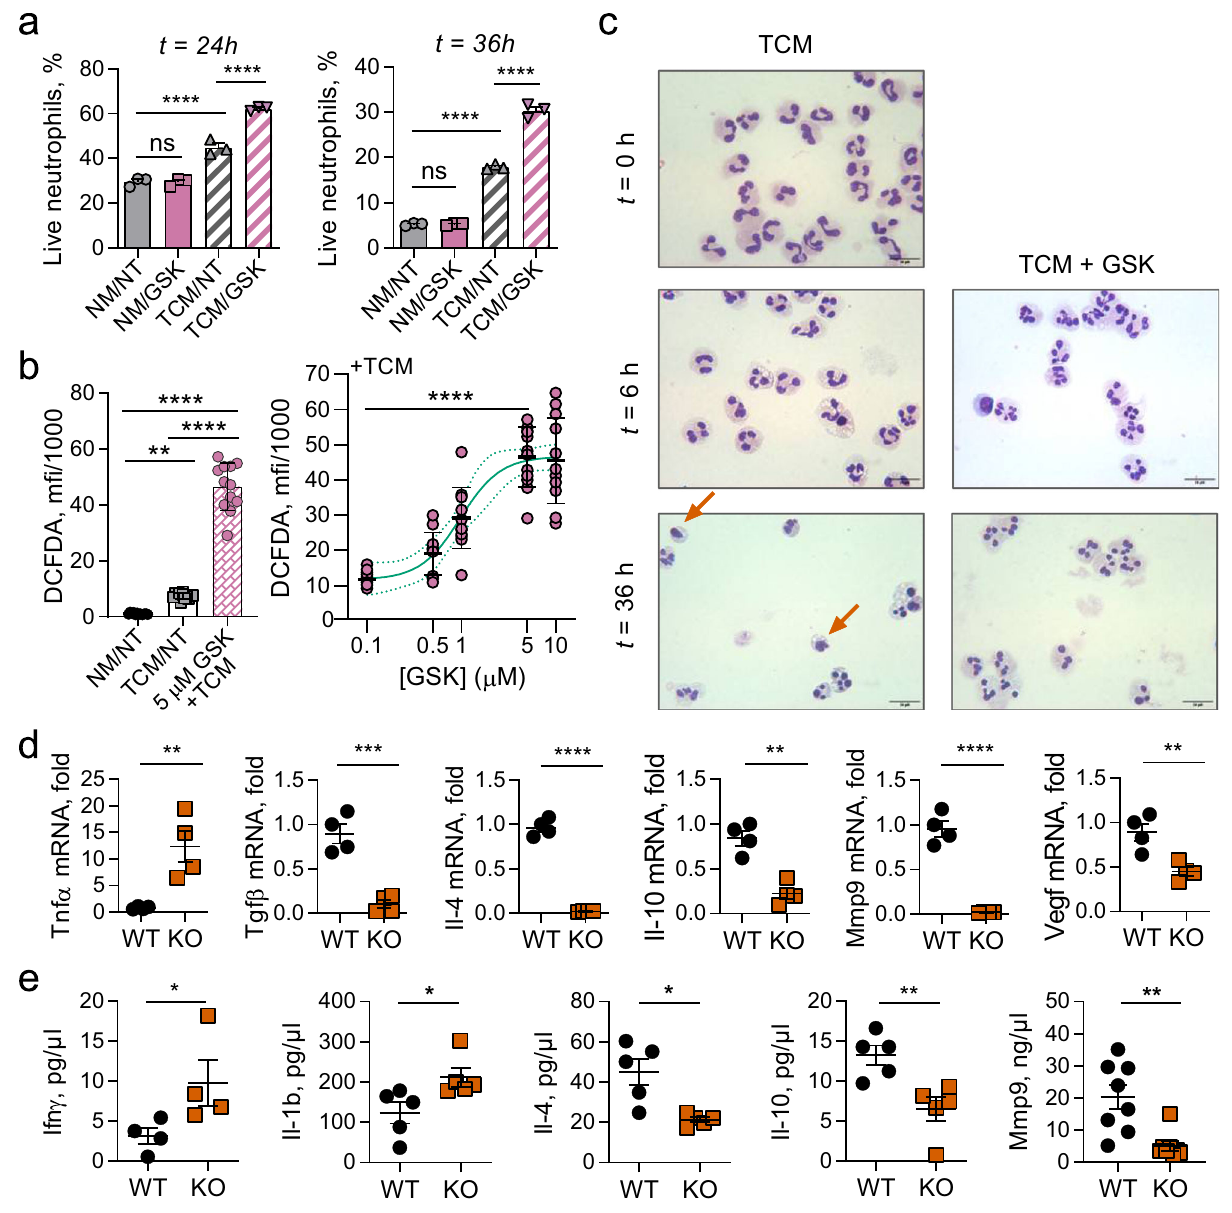
Fig. 3 Ppm1d -de fi cient mouse and Wip1-inhibited human neutrophils exhibit characteristics of N1 neutrophils. a Survival of human donor blood neutrophils. Freshly isolated neutrophils were cultured in regular media (NA) or in tumor-conditioned media (TCM) and treated with vehicle (NT) or 5 μ M GSK2830371 (GSK) for 24 h (left panel) or 36 h (right panel; n = 3 for each condition). b DFCDA (2 ′ ,7 ′ -dichloro fl uorescein diacetate) fl uorescence as an indicator of reactive oxygen species (ROS) production by donor blood human neutrophils preincubated with vehicle or the indicated concentrations of GSK2830371 for 6 h before activation with PMA ( n = 12 for each condition). One-way ANOVA with Kruskal – Wallis ’ multiple- comparison test, p < 0.05; **, p < 0.001; ****. c Morphology of human donor blood neutrophils cultured in tumor-conditioned medium (TCM) with vehicle (TCM) or 5 μ M GSK2830371 (TCM + GSK) for 6 or 36 h. Red arrows indicate apoptotic neutrophils with condensed nuclei. Cytospin spreads were stained with May – Grünwald Giemsa solution and visualized by light microscopy. Scale bar, 20 μ m (one representative experiment out of 6 is shown). d Relative mRNA levels of various cytokines in B16 melanoma tumors isolated 16 days after engraftment in Ppm1d + / + (WT) or Ppm1d KO2/KO2 (KO) mice ( n = 4 for each genotype). e Multiplexed bead-based (Luminex) determination of selected cytokine protein levels in B16 tumor lysates from Ppm1d + / + (WT) and Ppm1d KO2/KO2 (KO) mice ( n = 4 for each genotype for IFN ϒ , n = 5 for each genotype for Il-1b,4,10, and n = 8 for each genotype for MMP9). Data are depicted as means ± SEM. Student ’ s t test (two-tailed) ( d ), Mann – Whitney test (two-tailed) ( e ), or ordinary one-way ANOVA with Sidak ’ s multiple-comparison test ( a ): * p < 0.05; ** p < 0.01; *** p < 0.001; **** p < 0.0001. Source data are provided as a Source Excel Data fi